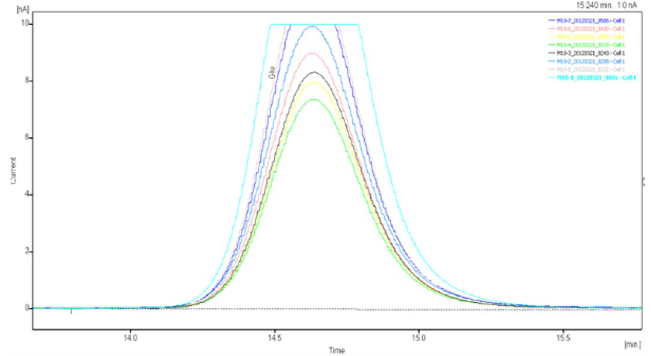
Figure 11. Glu high performance liquid chromatography4.